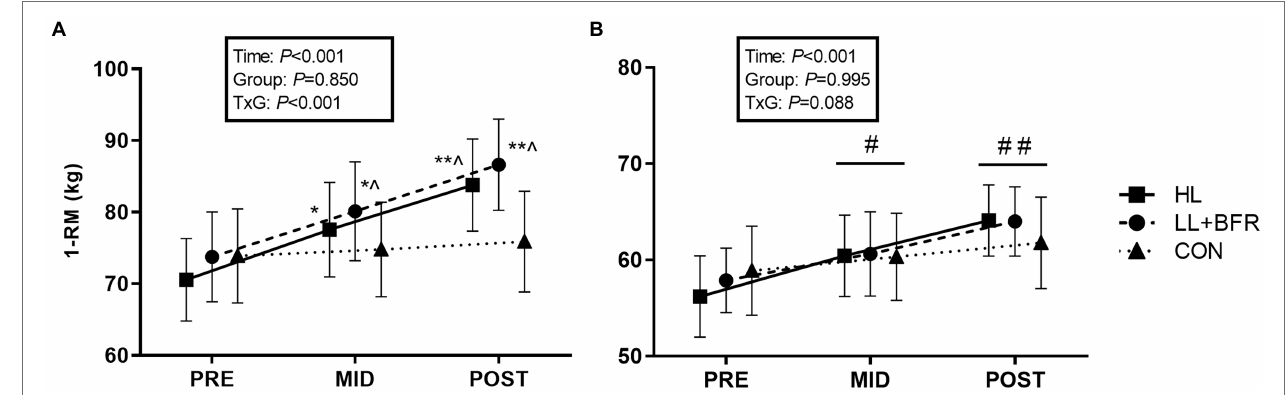
FIGURE 3 | One-repetition maximum (1-RM) strength for bilateral knee extension (A) and knee flexion exercises (B) in heavy-load resistance training (HL), blood flow restriction training (LL + BFR), and non-training control (CON) groups. Data are mean ± SEM. * Different from PRE ( p < 0.001); ** different from PRE and MID ( p < 0.001); ^ different from CON ( p < 0.01); # different from PRE (TIME main effect; p < 0.01); and ## different from PRE and MID (TIME main effect; p <